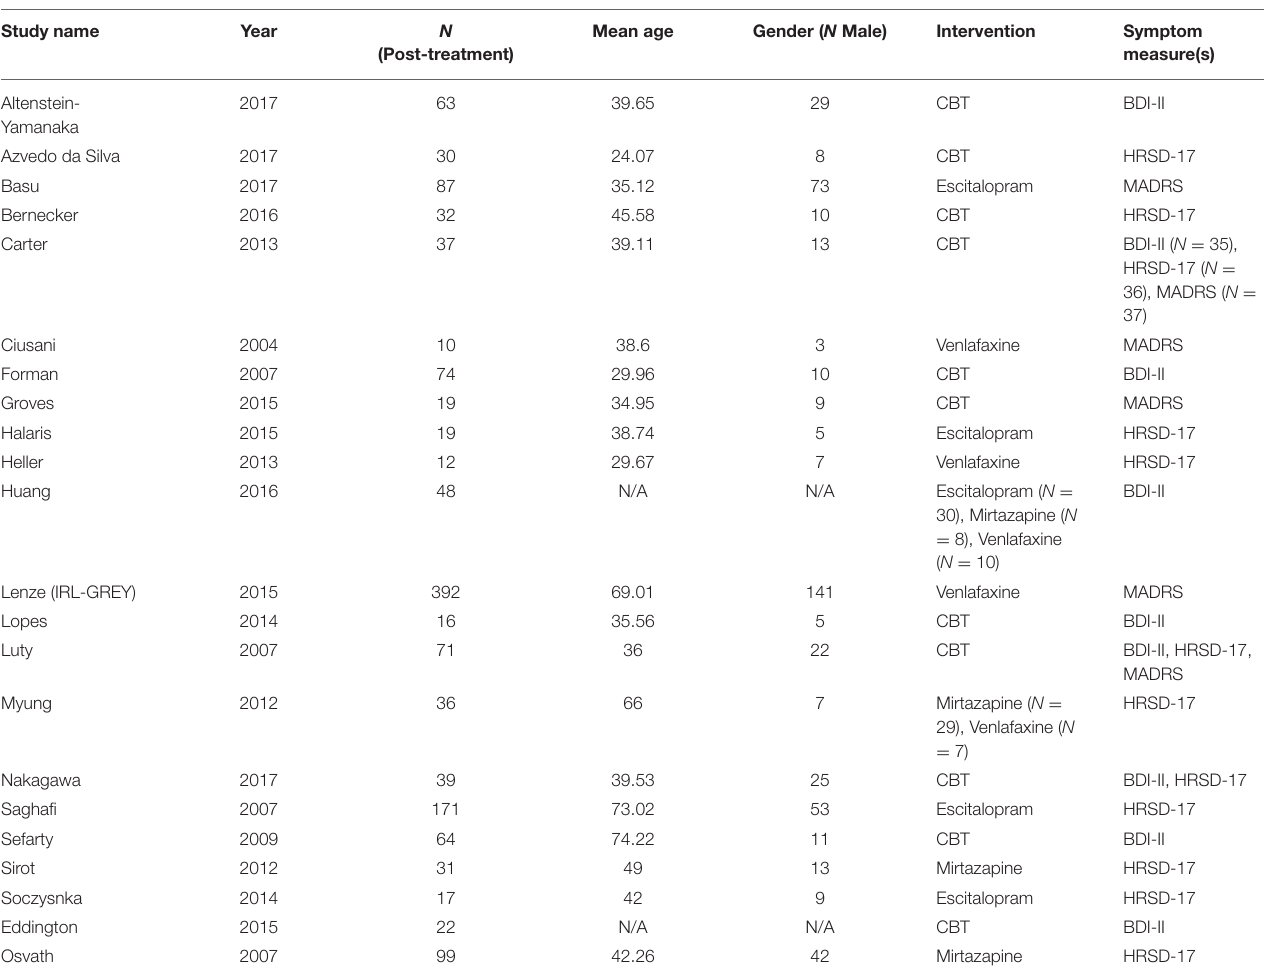
TABLE 1 | Study characteristics of the network analyzed